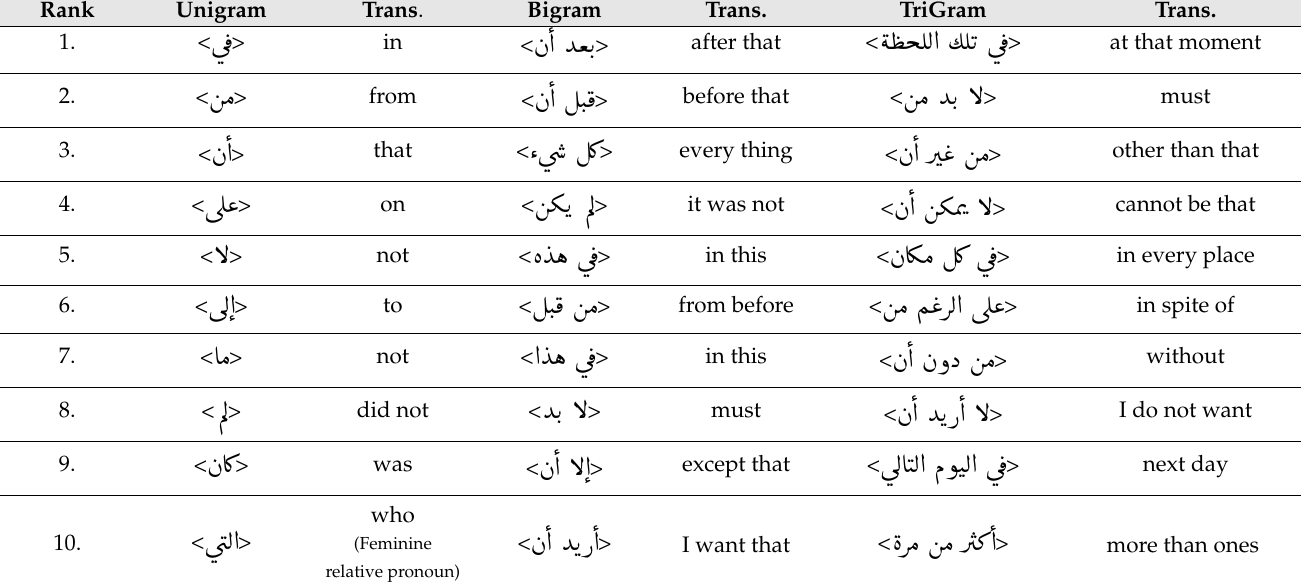
Table 3. The top ten uni-gram, bigram, and trigram in the Saudi Novel